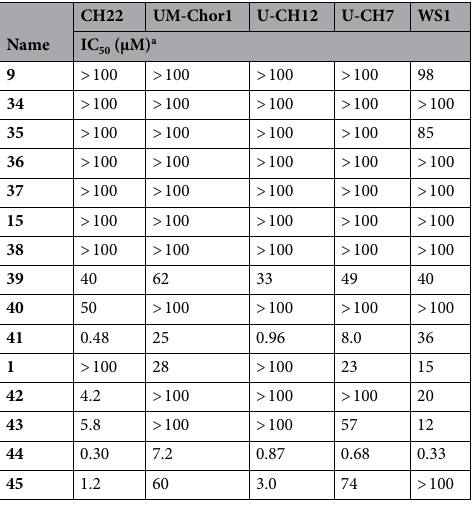
Table 6. Optimized derivatives of 1 , 9 and 15 across four additional patient-derived chordoma cell lines and WS1 control. a cell viability assay (n = 4).